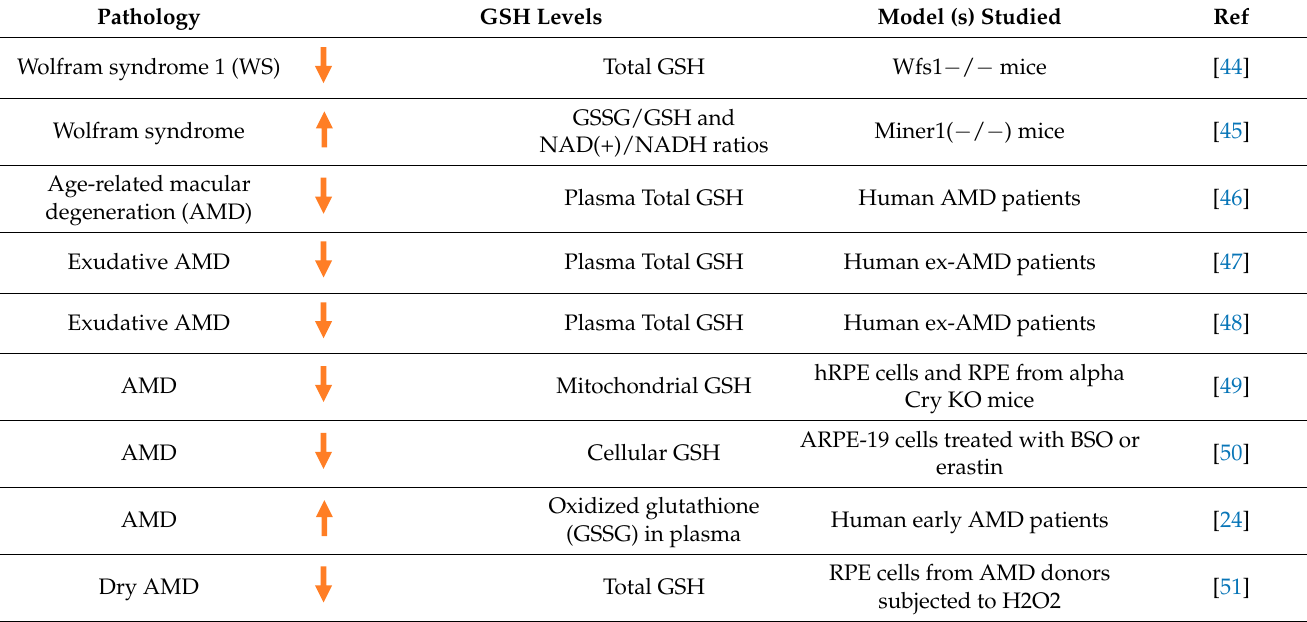
Table 1. Regulation of GSH in retinal diseases.